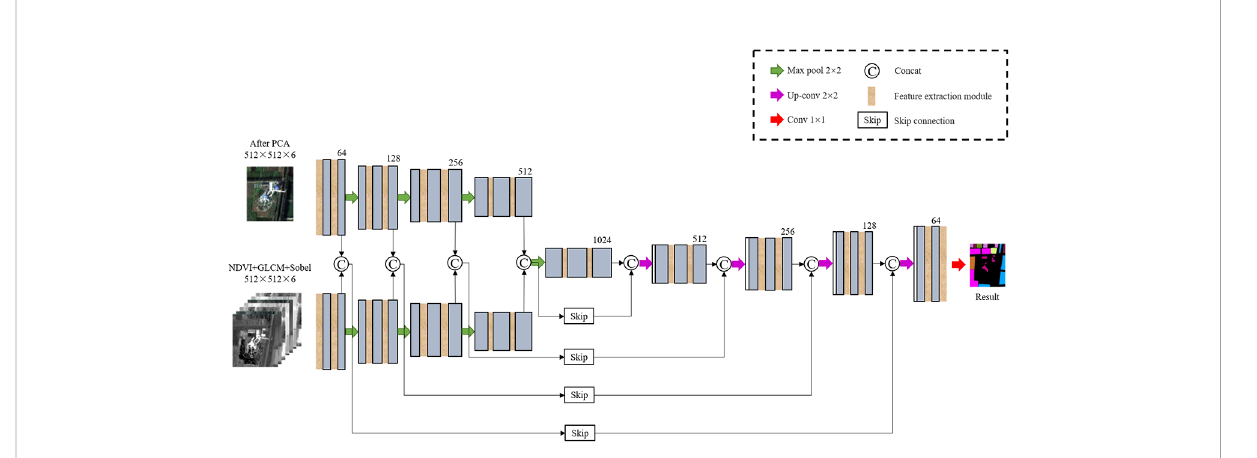
FIGURE 8 The dual-way input model based on improved